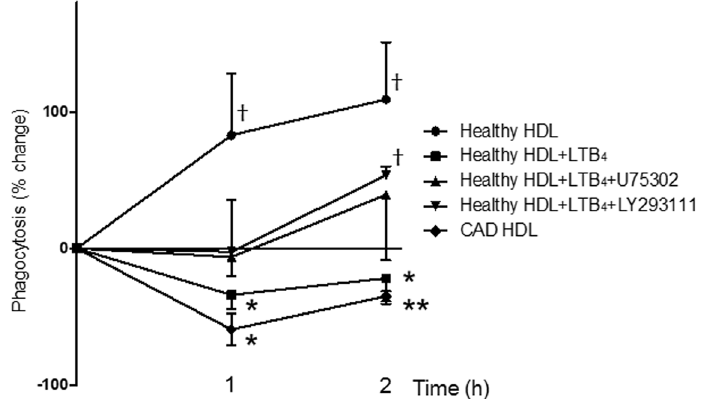
Figure 6. HDL Healthy enhanced macrophage phagocytosis. Macrophages (0.5 × 10 5 ) were pretreated with each HDL (10 µ g) for 1 h or 2 h at 37 °C and then incubated with fluorescent-labelled zymosan for 30 min at 37 °C. In specific experiments, LTB4 (100 nM) or BLT1 antagonist LY293111 (300 nM) or U75302 (300 nM) were used as pretreatment. The results are percentage increases of phagocytosis compared with that after vehicle treatment and are shown as the mean ± SEM, N = 4. † P < 0.05 compared to vehicle. * P < 0.05, ** P < 0.01, versus HDL Healthy